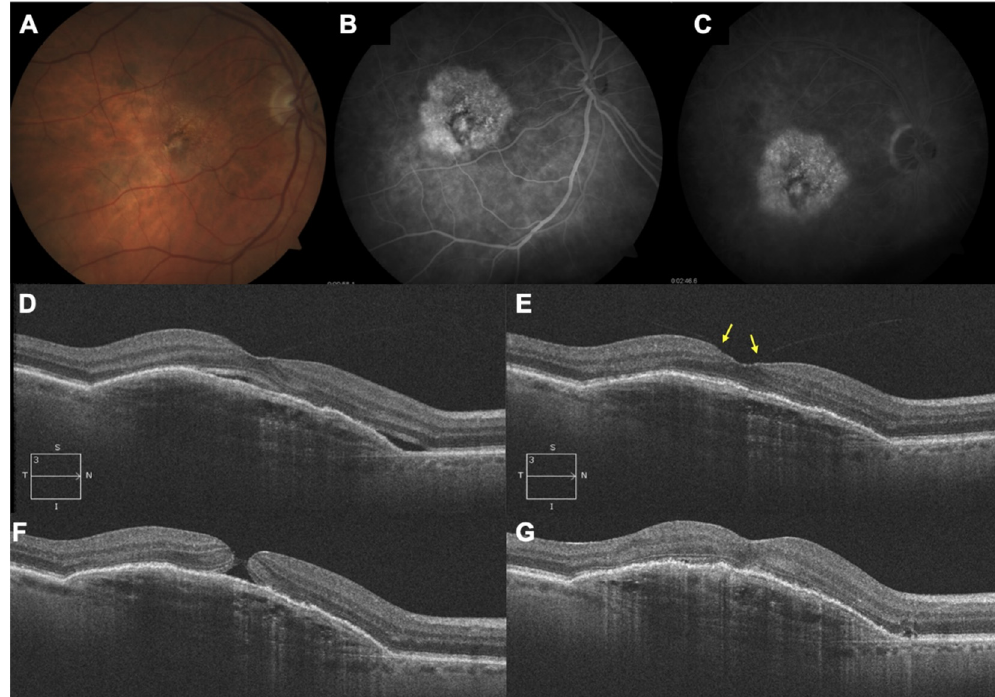
Figure 3. A 78-year-old male patient had been treated for neovascular AMD with aflibercept and ranibizumab and had received 50 injections overall prior to switch to brolucizumab. ( A – C ) Multimodal imaging at baseline showing a large subfoveal lesion. ( D ) SD-OCT immediately prior to initiation of brolucizumab therapy. ( E ) SD-OCT 8 weeks after the first brolucizumab injection showing a total resorption of the subretinal fluid but also an evident vitreomacular adherence (arrows). ( F ) SD-OCT 15 days after receiving his 5th brolucizumab injection, showing macular hole. SD-OCT after the macular hole surgery. ( G ) C-late phase FFA.